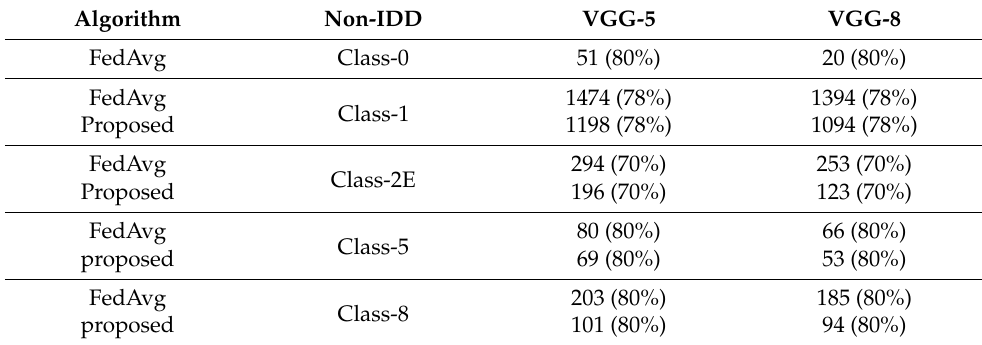
Table 1. The number of communication rounds required to obtain the targeted